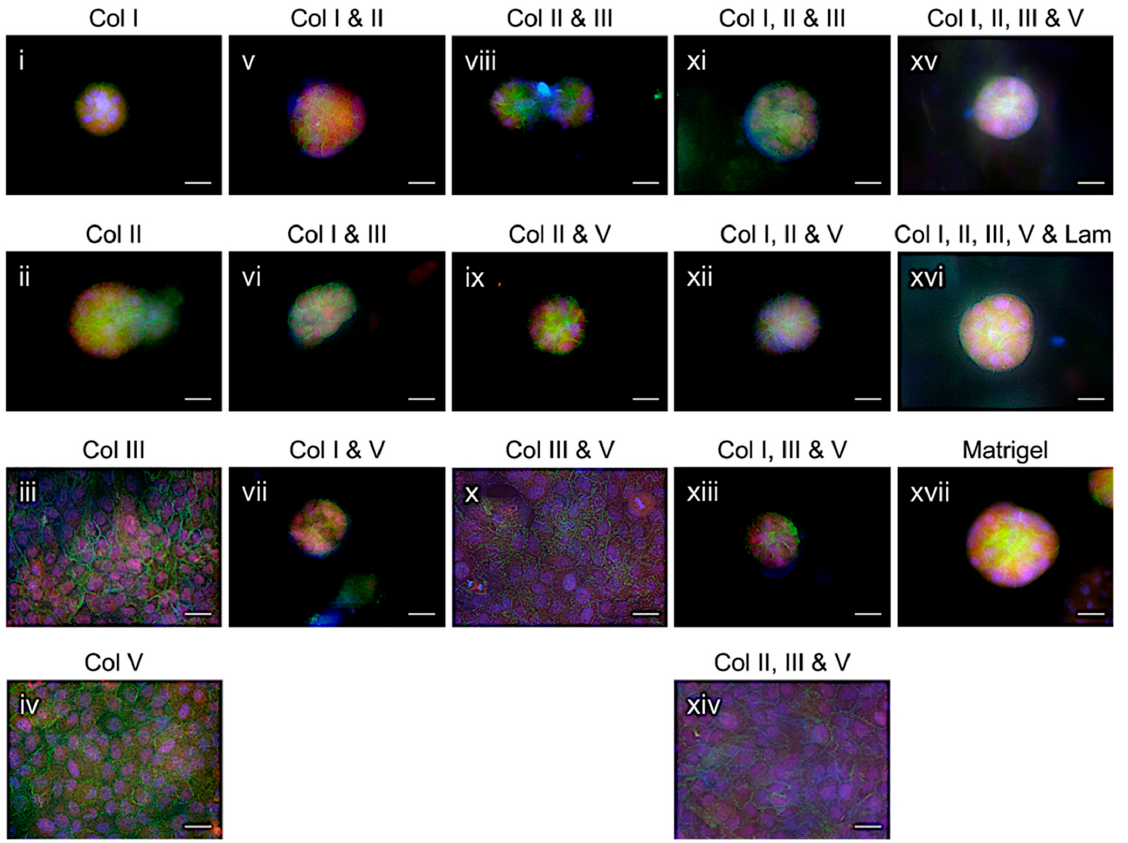
Figure 4. MCF10A cell acini formation on a single type or a combination of the different types of collagens commonly identified in HB-TMG, PB-TMG, and MB-TMG. IF staining was used to exam- ine the acini formation on Col I (i); Col II (ii); Col III (iii); Col V (iv); Col 1& Col II (v); Col I & Col III (vi); Col I & Col V (vii); Col II & Col III (viii); Col II & Col V (ix); Col III & Col V (x); Col I, Col II & Col III (xi); Col I, Col II & Col V (xii); Col I, Col III & Col V (xiii); Col II, Col III & Col V (xiv); Col I, Col II, Col III & Col V (xv); Col I, Col II, Col III, Col V & laminin (xvi). Acini formation on Matrigel was included as a positive control (xvii). Green, E-cadherin; red, β 4-integrin; blue, nuclei stained with Hoechst. Scale bars, 50 μ M.